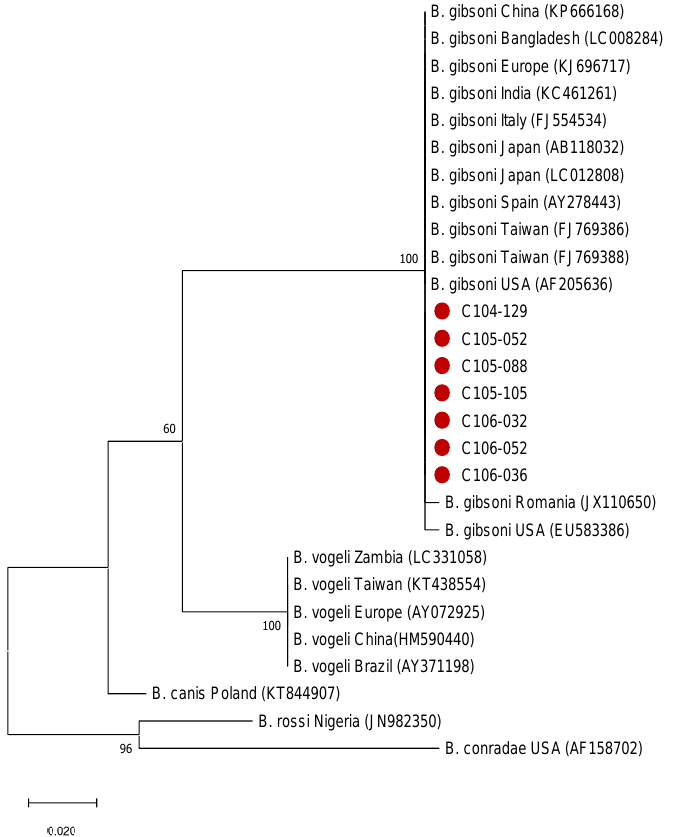
Figure 2. Phylogenetic tree of B. gibsoni . Phylogenetic relationships based on the 18S rRNA gene of Babesia isolates were constructed by the maximum likelihood method based on the Kimura 2-parameter model with 1000 bootstrapping replicates to determine every internal node. The red circles represent the Babesia gibsoni strains in this study.